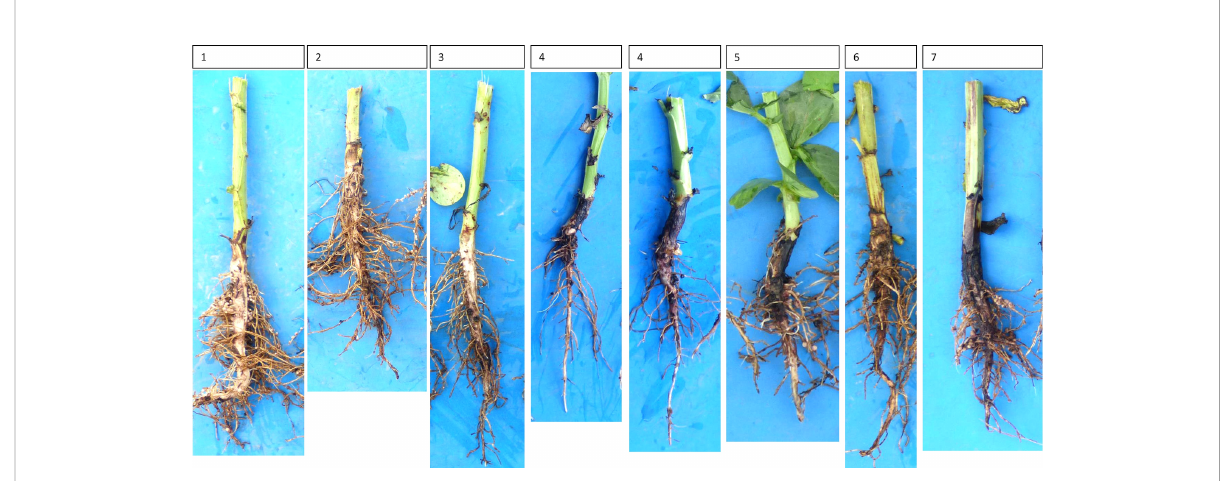
FIGURE 2 Varying root discoloration levels and the assigned root rot disease severity ratings (1=healthy plant, 9=dying plant). Plants with disease severity ratings of 8 and 9 (i.e. severe rots) were not observed during the